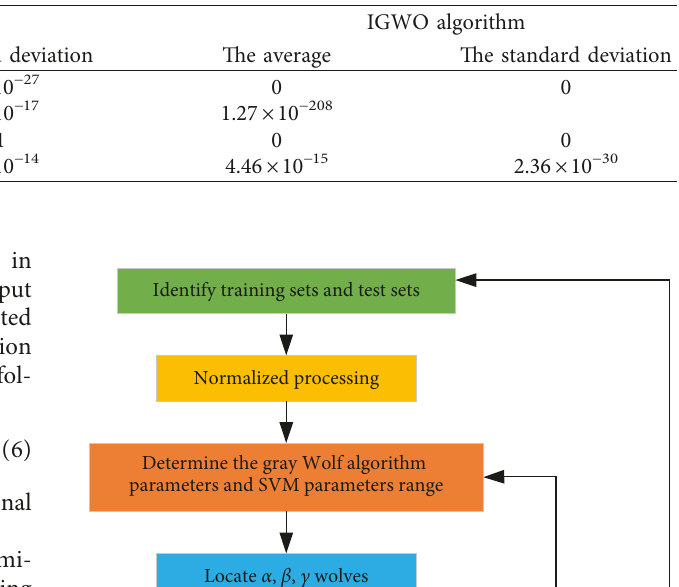
Table 2: Test result functions of different algorithms.